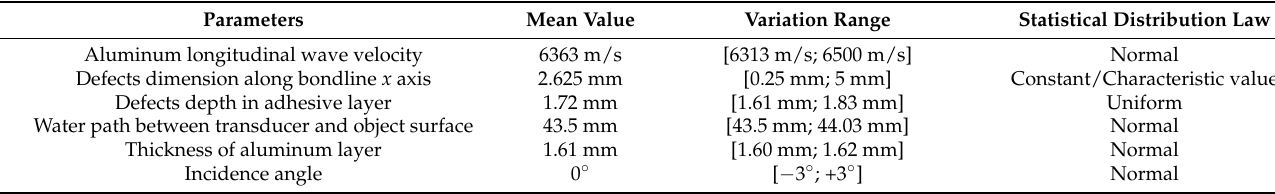
Table 1. Variation range of influential parameters.